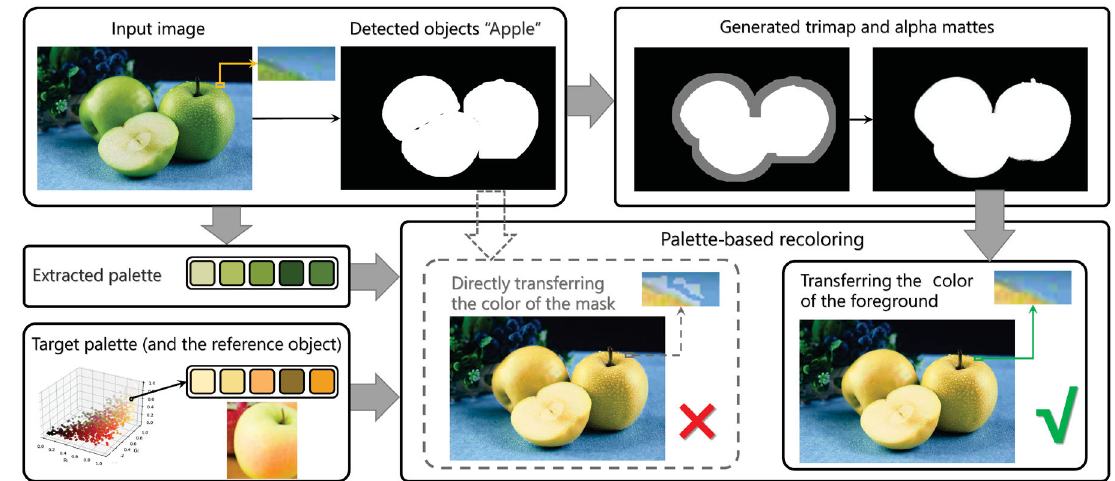
Fig. 2 Pipeline. We detect each object in the image and generate the palette based on the mask. We use alpha matting to process the mask and get the alpha matte of the object. Finally, we transfer the foreground color using the target palette chosen by the user.